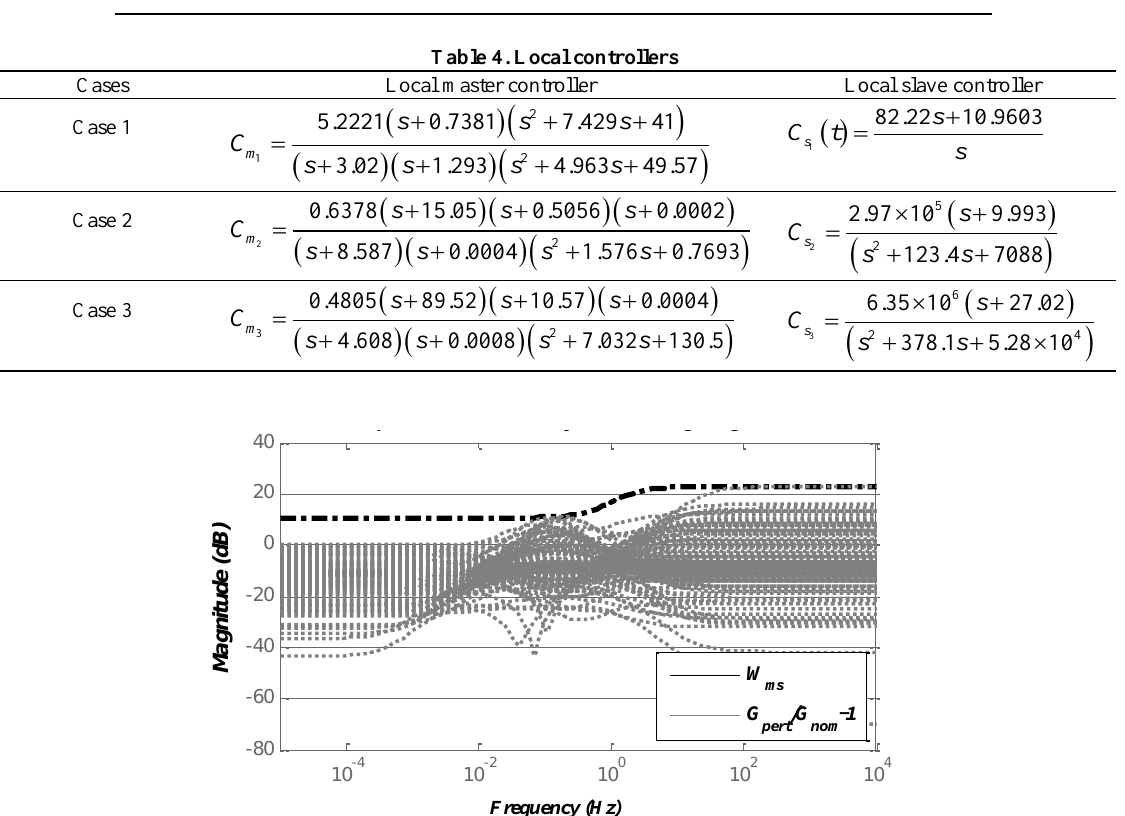
Figure 8a. Bode diagram of the weighting function W ms for the uncertain slave system G/G 0 -1